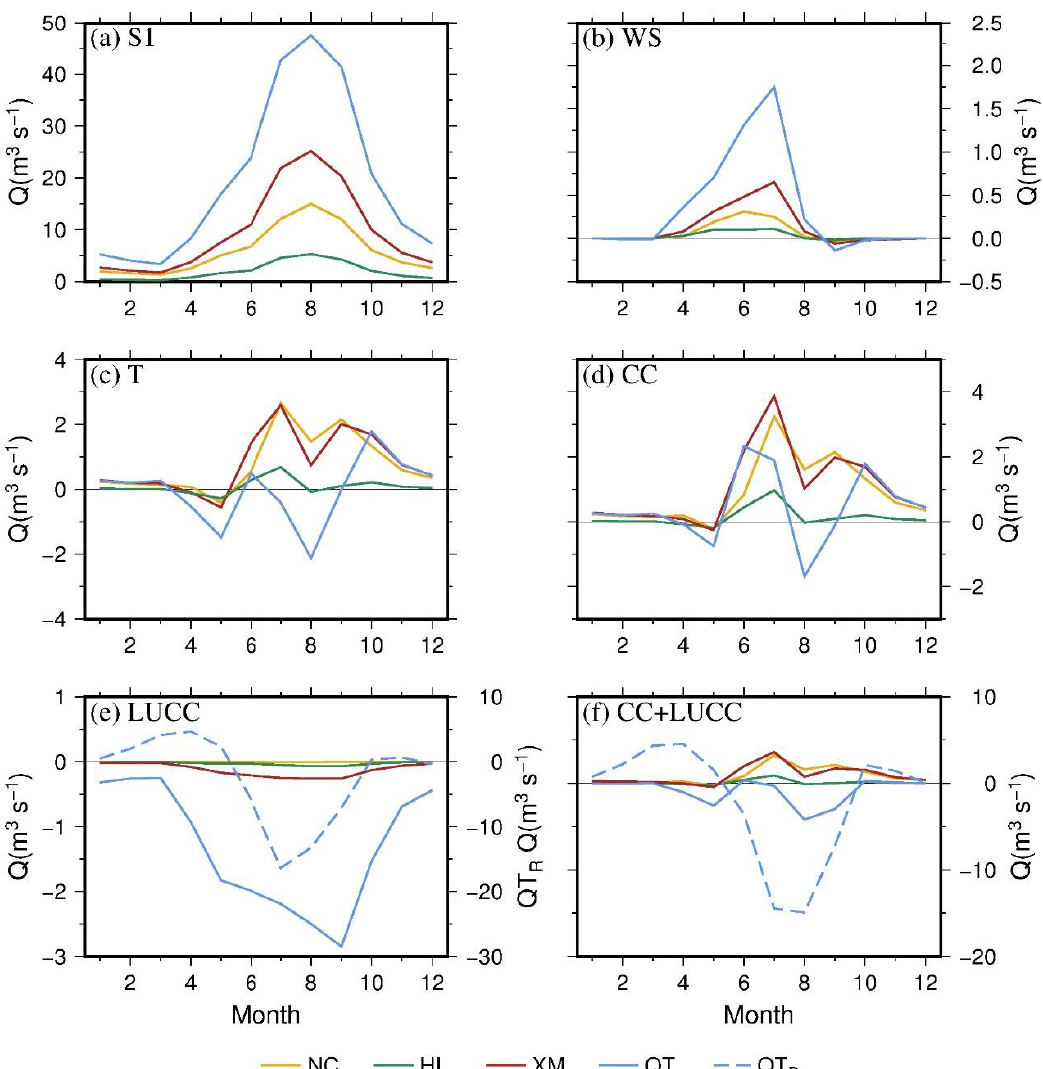
Figure 5. Monthly streamflow of baseline scenario S1 ( a ) and its change in scenarios of wind speed change ( b ); temperature change ( c ); wind speed and temperature change, that is, climate change ( d ); land use/cover change ( e ); and both climate change and land use/cover change ( f ). QT R represents Qiaotou streamflow change caused by land use/cover change, which covered reservoir regulation (the same below for QT R ).